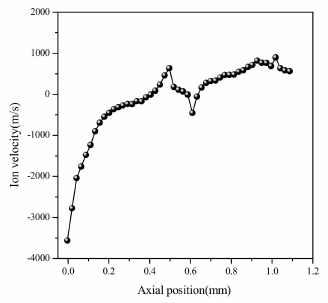
Figure 8. The axial average velocity of ions versus axial position (400 A, 100 V, 4 g /